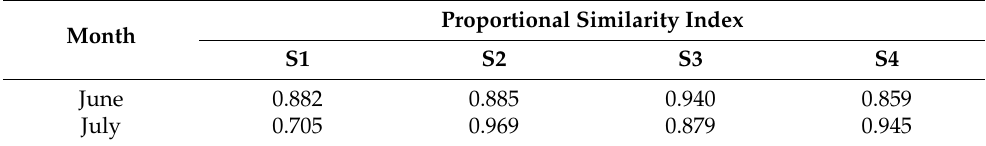
Table 2. Proportional similarity index of plants in different